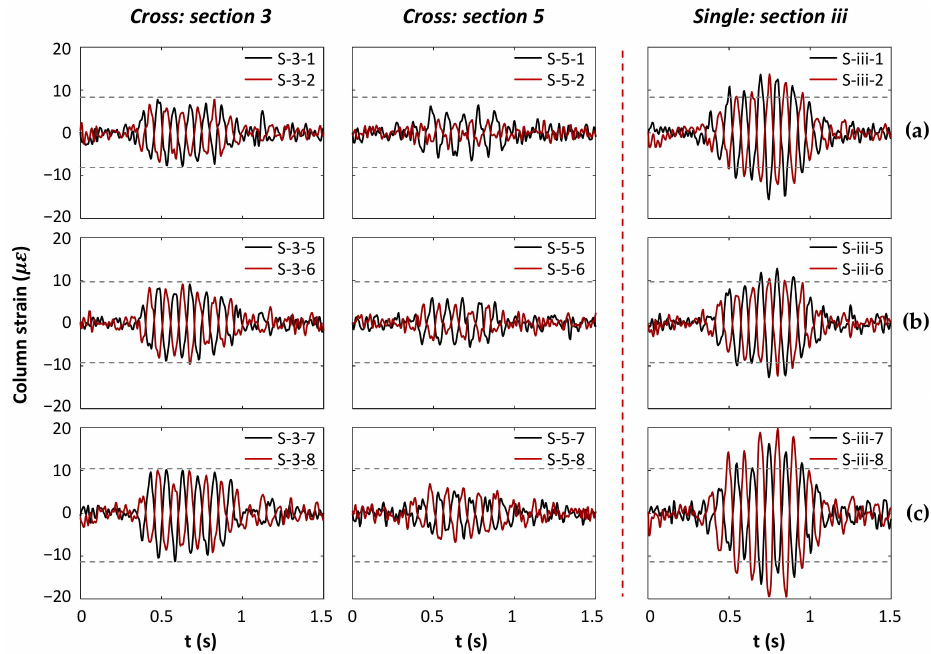
Figure 12. Comparison of dynamic strain recorded on columns in the two-story part of the inter- change station ( section 3 and section 5 ) and the single station ( section iii ) at ( a ) the top end of the upper column, ( b ) the top end of the lower column and ( c ) the bottom end of the lower column during the sinusoidal excitation with a dominant frequency of 10